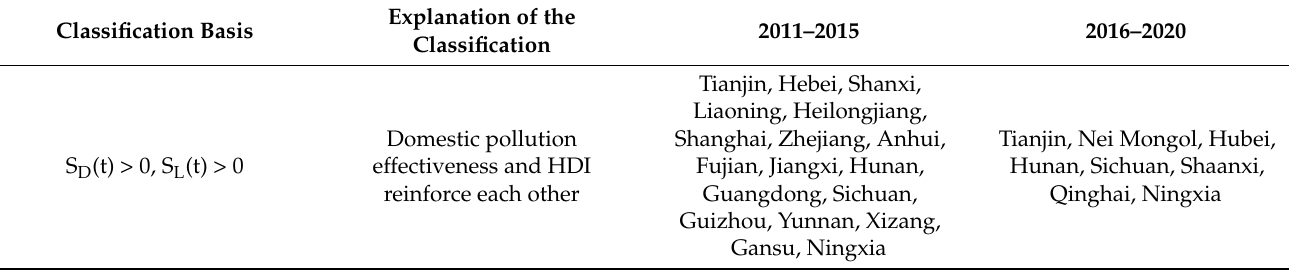
Table 3. Classification of the force-on index of domestic pollution